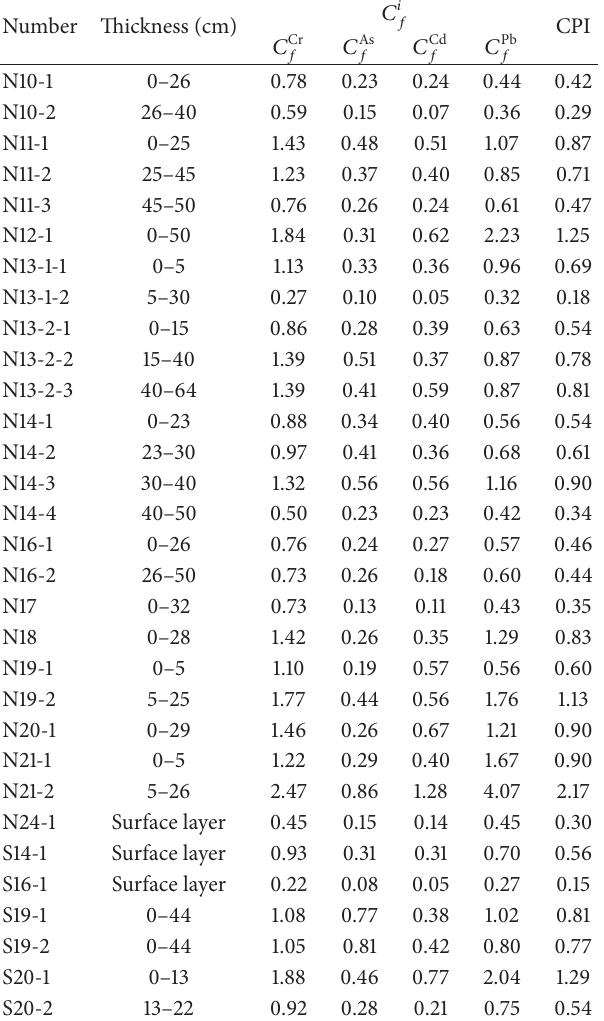
Table 5: Assessment of heavy metal pollution degree risks in sediment. Number Thickness (cm)